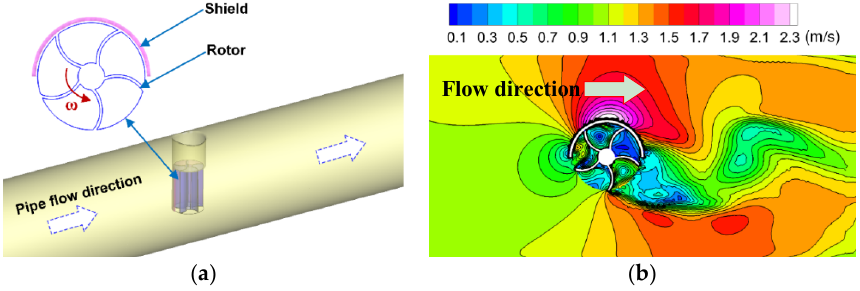
Figure 16. Savonius rotor and the semi-circular shield in the pipe: ( a ) schematic view [53]; ( b ) cross-sectional velocity distribution.